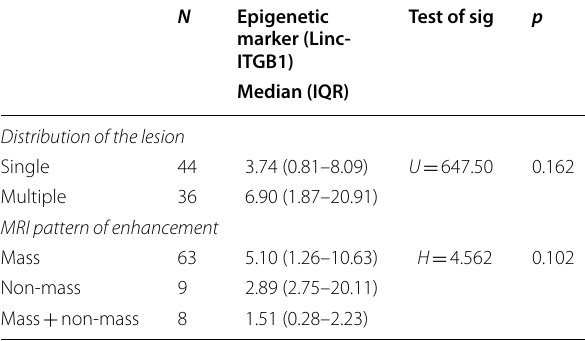
Table 11 Relation between the epigenetic marker (Linc‑ITGB1) and the type and distribution of the lesion in MRI ( n